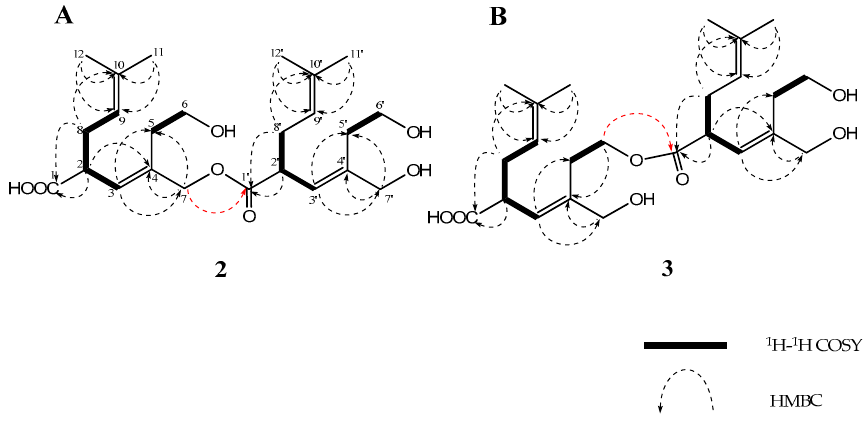
Figure 3. Selected 1 H– 1 H COSY and HMBC correlations of 2 ( A ) and 3 ( B ).